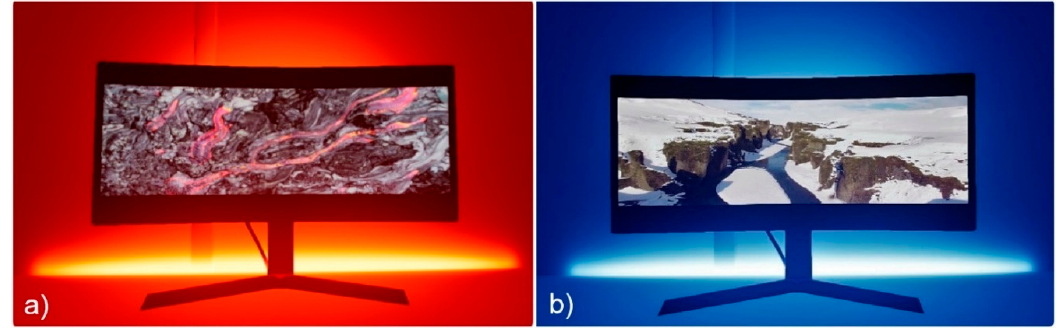
Figure 6. Virtual scenario: ( a ) red setting; ( b ) blue setting.